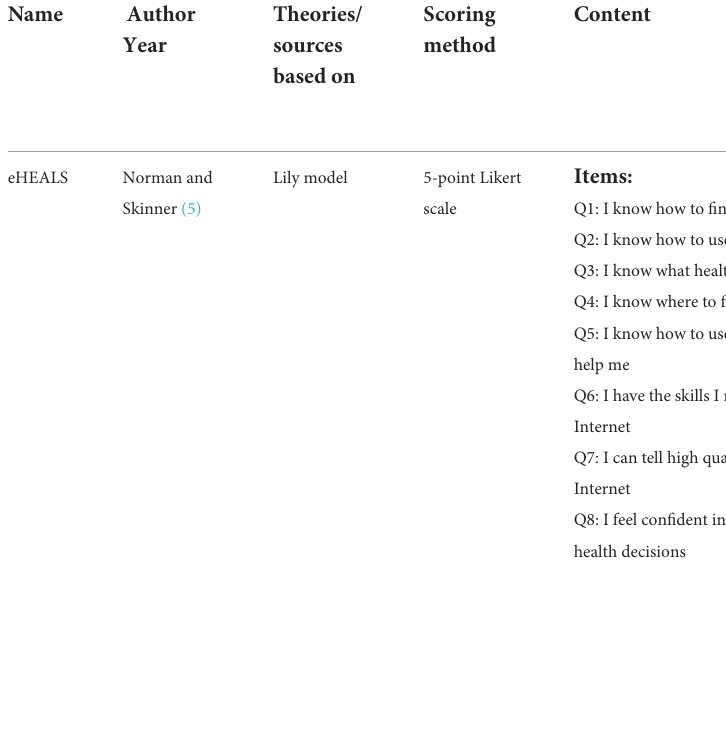
TABLE 2 DHL assessment tools for older